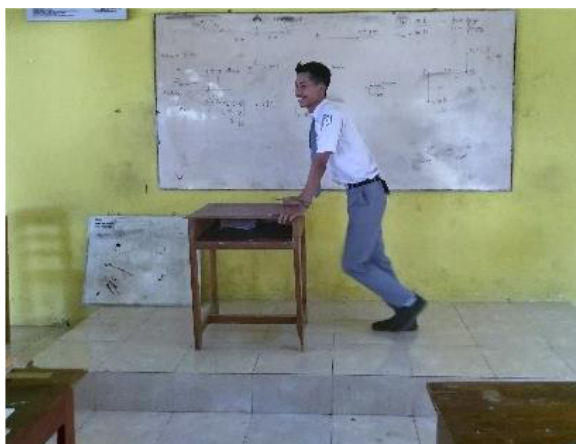
Figure 6: Students try to practice.